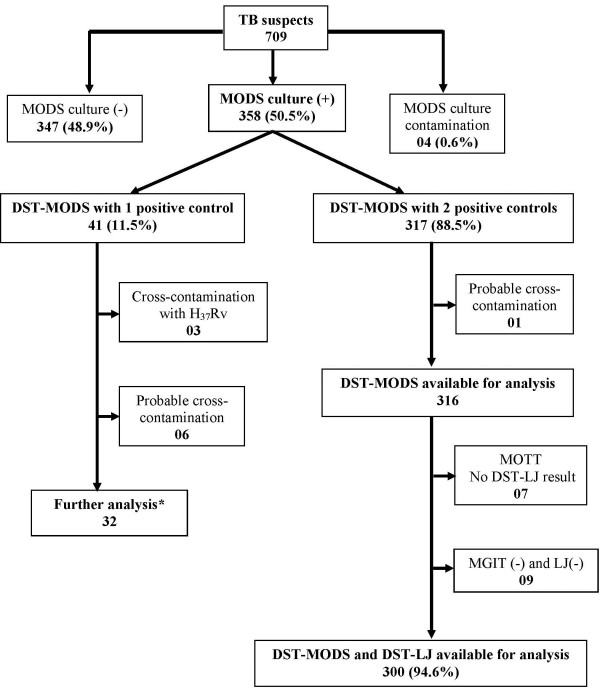
Recruitment flow chart. MOTT: Mycobacteria Other Than Tuberculosis. DST-MODS: Drug susceptibility testing done by MODS. DST-LJ: Drug susceptibility testing done by 1% proportional method on LJ media. (*) Analysis based on DST/LJ and MAS-PCR because DST/MODS results were recorded as uninterpretable